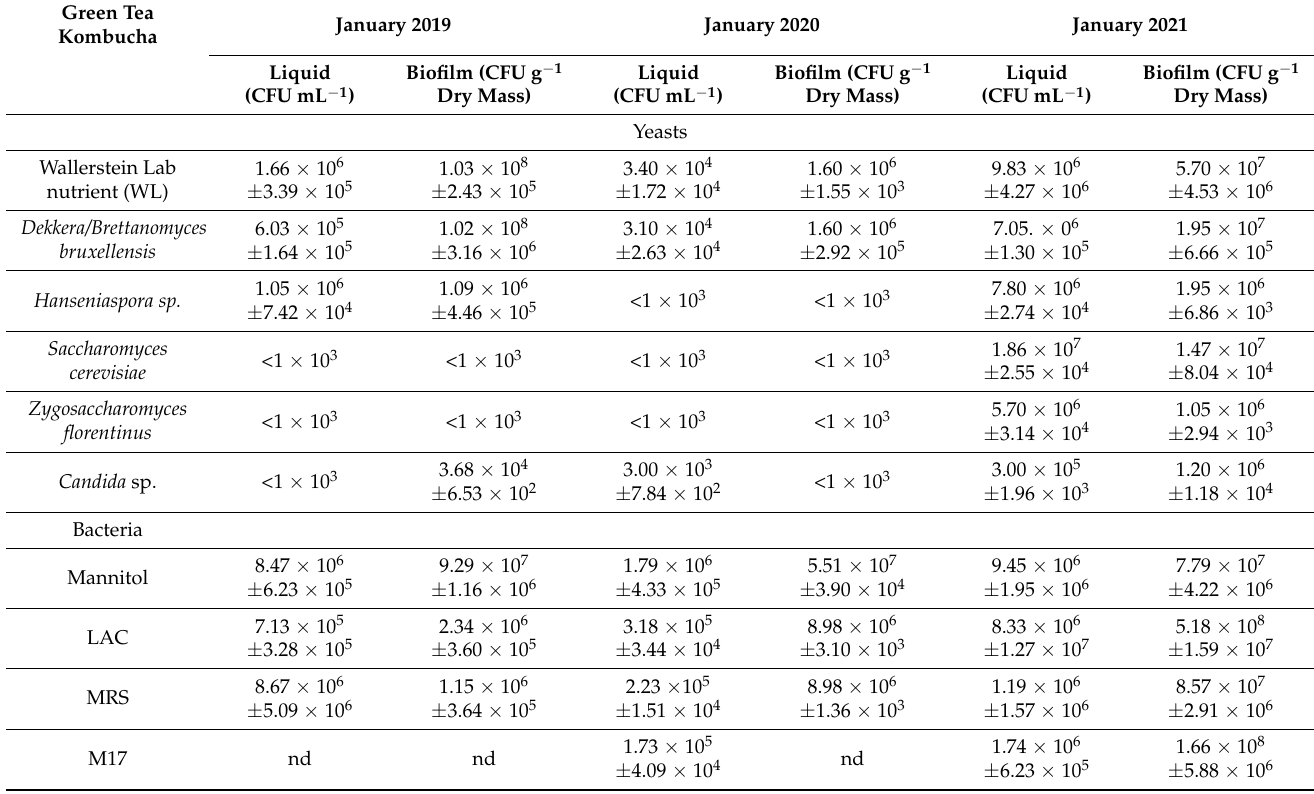
Table 1. Populations in yeasts and bacteria in green tea kombucha liquid and biofilm samples over three years (expressed as: average value ± confidence interval with α = 0.05). nd = not